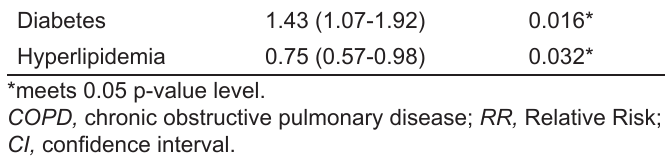
*meets 0.05 p-value level. COPD, chronic obstructive pulmonary disease; RR, Relative Risk; CI, confidence